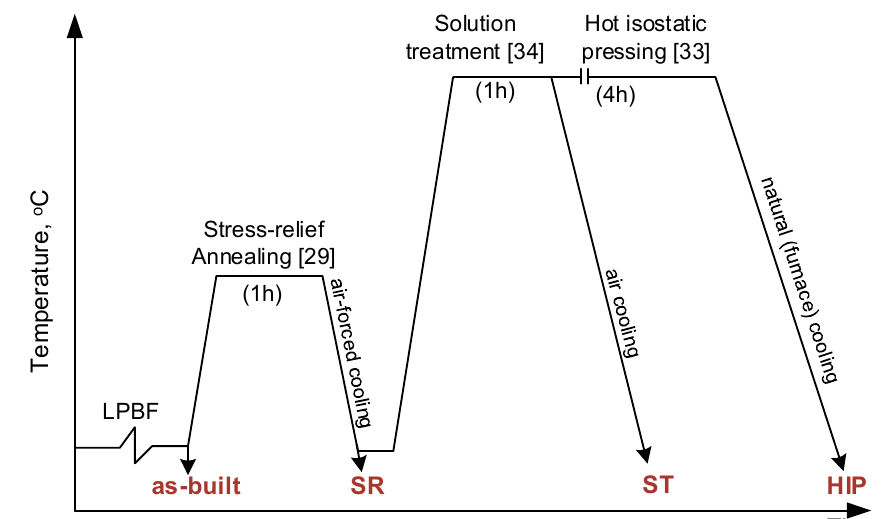
Figure 2. Schematic presentation of the post-processing sequence of laser powder bed fusion (LPBF) alloy.